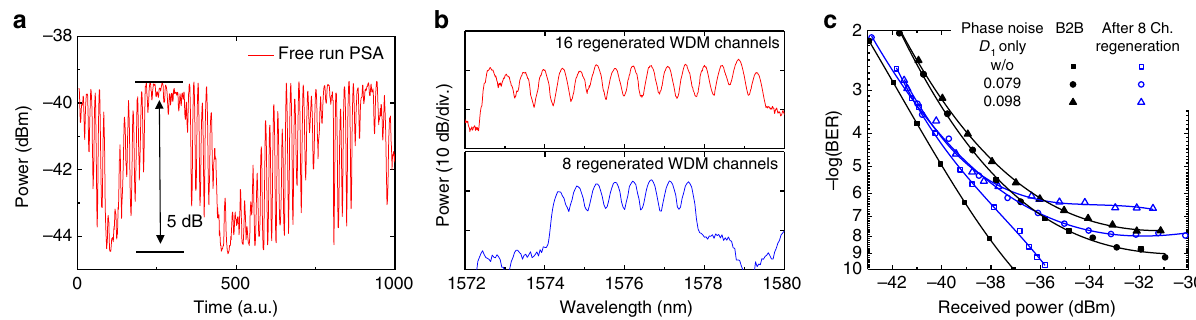
Fig. 6 Measured PSA regeneration performance. a The PSA phase-sensitive response with 160 GBd signal. b A zoom-in on the idler of the second OFT. c BER measurements of 8-channel WDM regeneration with only the fi rst noise emulator PM1 ( D 1 =